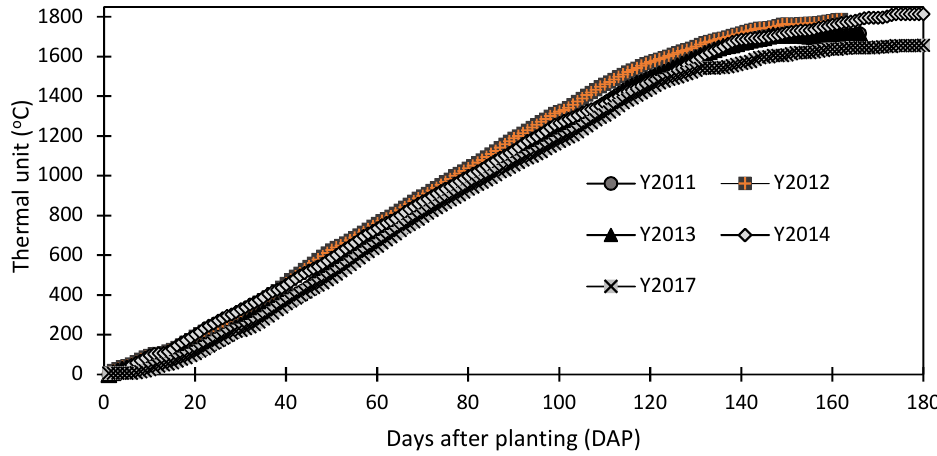
Figure 3. Cumulative thermal units in the 2011, 2012, 2013, 2014 and 2017 growing seasons at the experimental site.